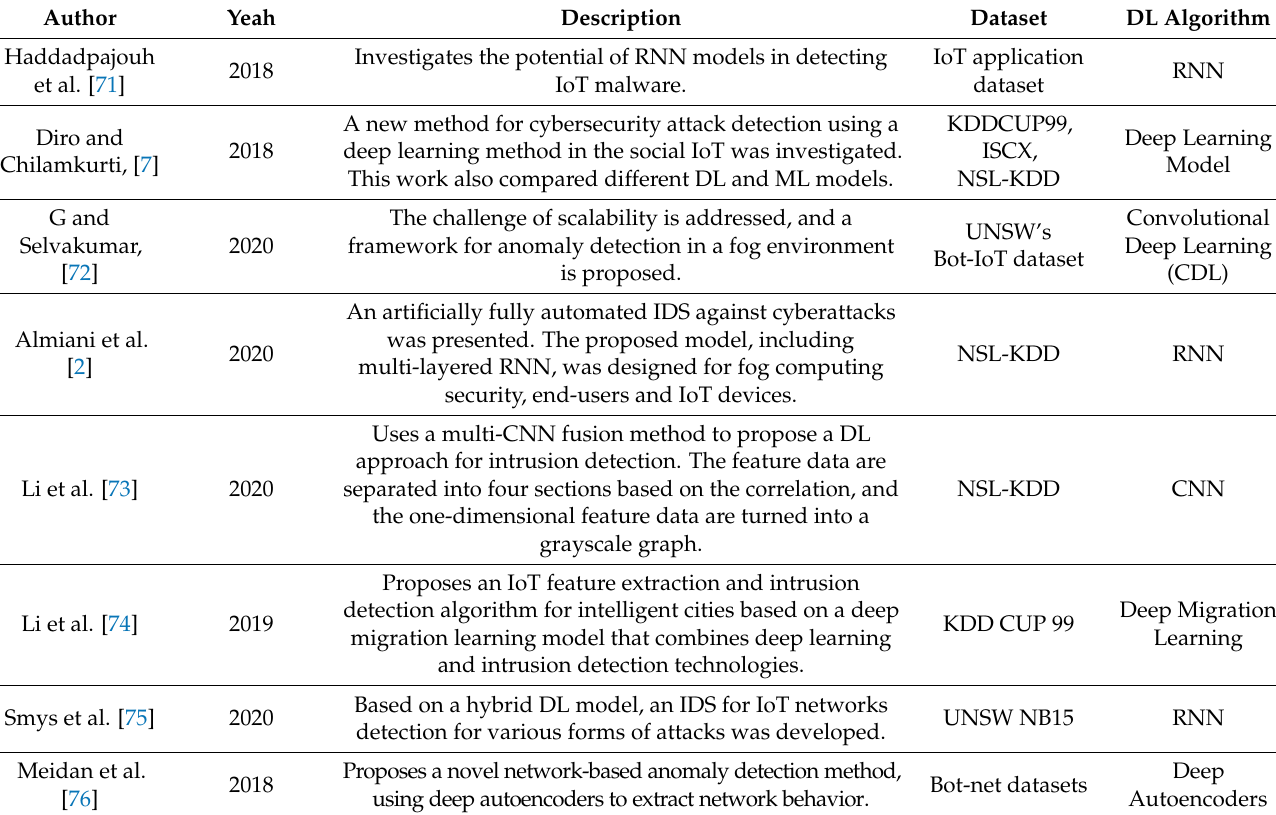
Table 5. Summary of studies classified based on DL